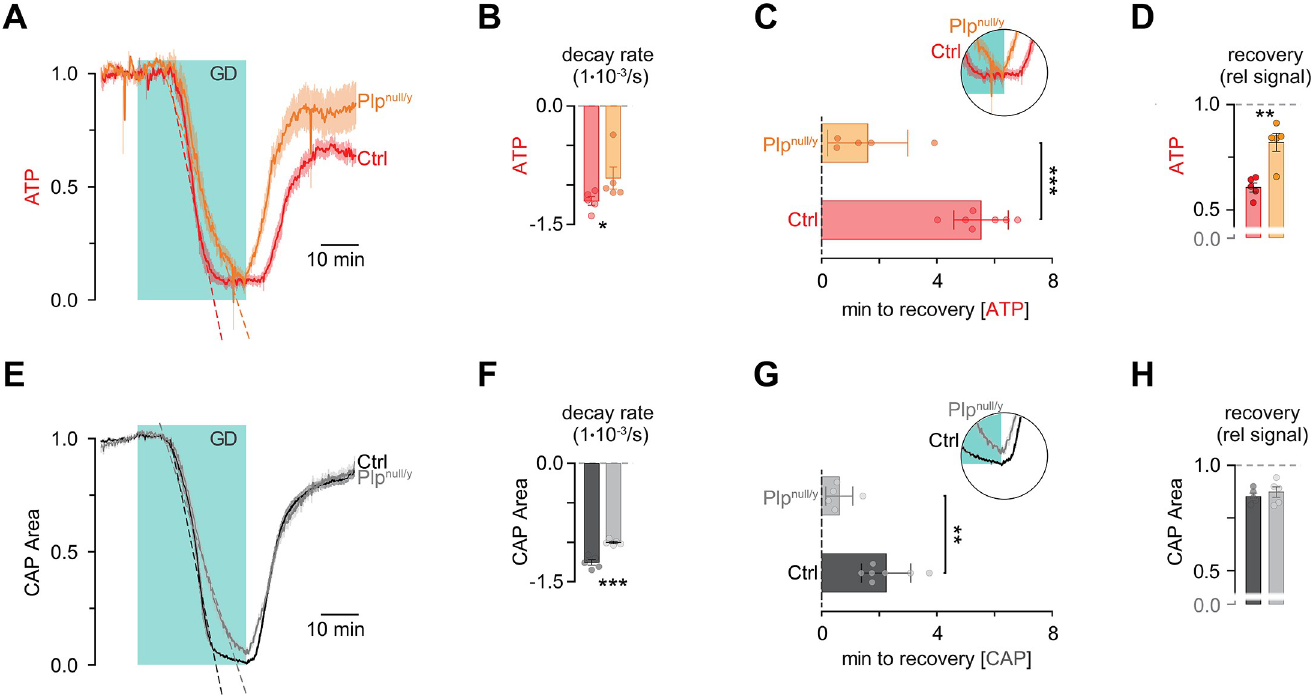
Fig 4. ATP levels in optic nerves from Plp null/y mice recover faster and more completely from glucose deprivation (GD). Optic nerves from Plp wt/y (control [Ctrl]) or Plp null/y mice were challenged by GD for 30 min (indicated by the light blue box). Afterwards, glucose (10 mM) was reperfused for an additional 45 min. (A) Time course of the ATP sensor signal in Ctrl and Plp null/y mice. (B) Rate of ATP sensor signal decay. (C) Delay time of the onset of recovery of the ATP sensor signal after the start of reperfusion with glucose. (D) Amplitude of recovery of the ATP sensor signal after reperfusion with glucose. (E) Time course of compound action potentials (CAPs) in Ctrl and Plp null/y mice. (F) Rate of CAP decay. (G) Delay time of the onset of recovery of CAP after the start of reperfusion with glucose. (H) Amplitude of recovery of CAP after reperfusion with glucose. n = 5 (Ctrl; B, D, F, H), 7 (Ctrl; C, G), and 5 ( Plp null/y ) optic nerves from N = 5, 7, and 5 mice, respectively. � p < 0.05, �� p < 0.01, ��� p < 0.001; Student t test. Data underlying this figure can be found in S1 Data.